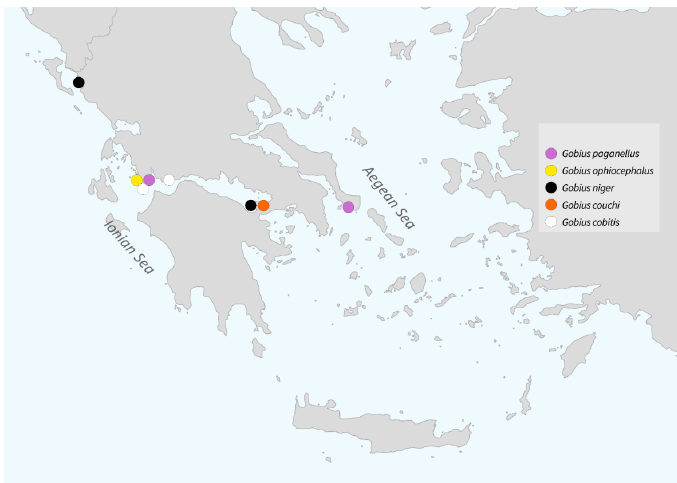
Figure 2. Species and localities sampled for gobies and parasites; see Table 2 for more sampling information. Table 2. Non-sand gobies inspected for monogenean ectoparasites and hosts sequenced for host identification in this study.